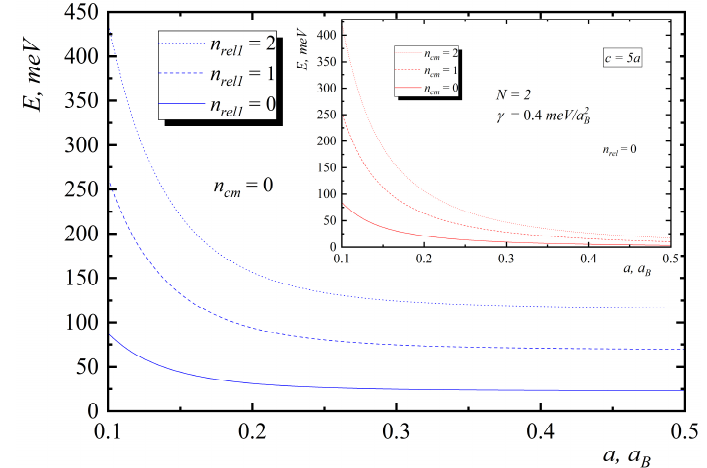
Figure 6. Energy diagram for three-particle system for the following values: I. γ = 0, II. γ = 0.05 meV / a 2 III. γ = 0.1 meV / a 2 . B